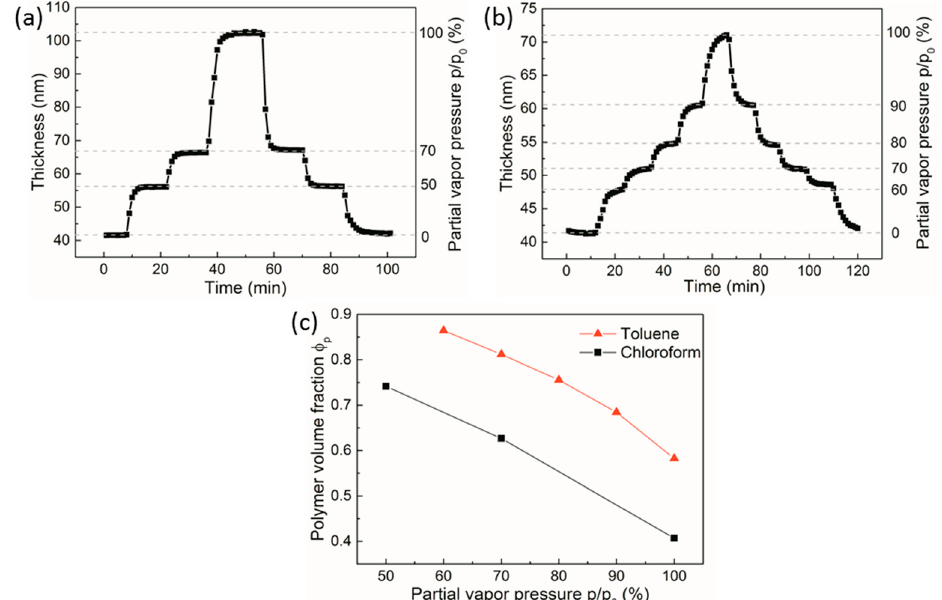
Figure 3. Swelling kinetics of PS-PVP ~40 nm thick films in ( a ) chloroform and ( b ) toluene vapor under stepwise increase of the partial vapor pressure by mixing the flows of Channel 1 and Channel 2 (Figure 1). T v and T s were kept constant at 19 and 20 ◦ C, respectively. ( c ) Polymer volume fraction of PS-PVP films in chloroform (black square) and in toluene (red triangle) versus partial vapor pressure of the respective solvent.